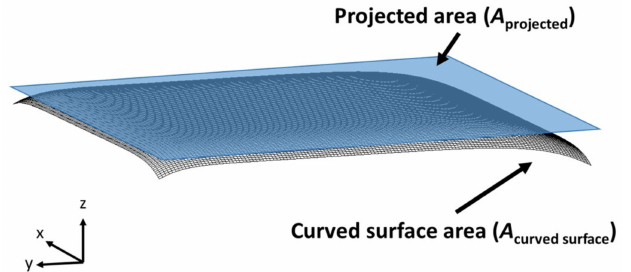
Figure 3. Schematic illustration of the curved surface in this